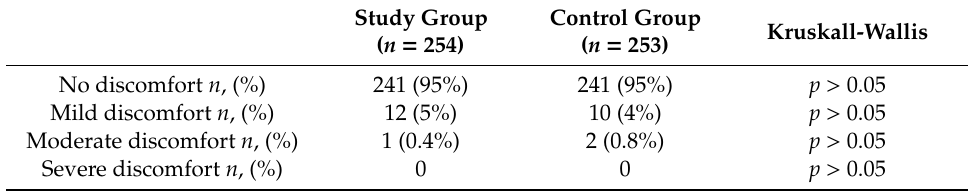
Table 5. Eye discomfort assessment in the two group throughout the study